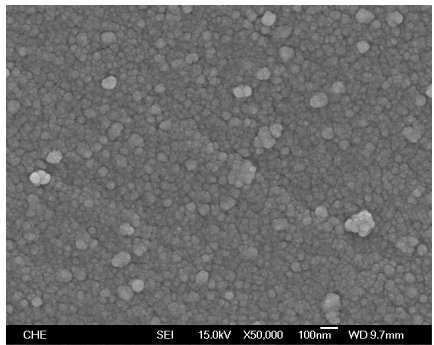
Figure 7. Scanning electron micrograph of spent Re-04RuSi catalyst. Nanomaterials 2018 , 8 , x FOR PEER REVIEW